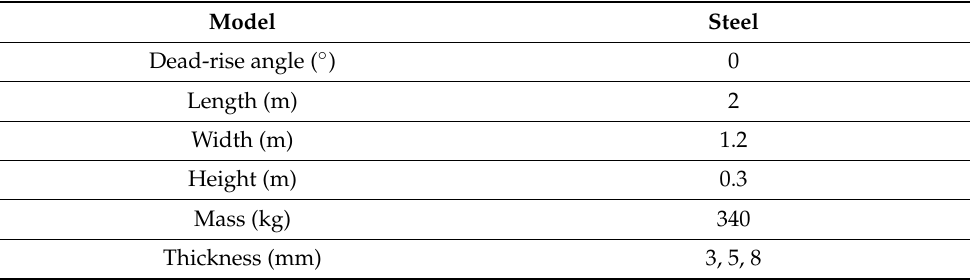
Figure 1. Wet drop test setup [3]. Table 1. Principal dimension of steel plate used in current study [3].